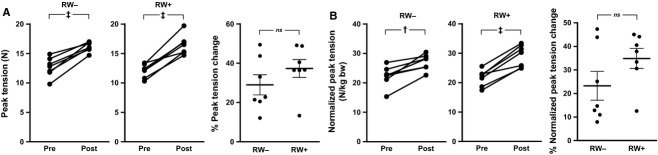
Bilateral forelimb grip strength testing. “Pre” and “post” study testing began on the 12th day before start of the RW protocol (d-12) and 52nd day of RW protocol (d52), respectively. Peak tension change (A, left), percent peak tension change (A, right), change in peak tension normalized to body weight (B, left), and percent normalized peak tension change (B, right). Values represent the daily mean across four consecutive days of testing (four tests per day). The horizontal bars in the dot plots represent the mean ± SE. †P < 0.01, ‡P < 0.001, ns not significant. RW−, no running wheel access; RW+, continuous running wheel access.